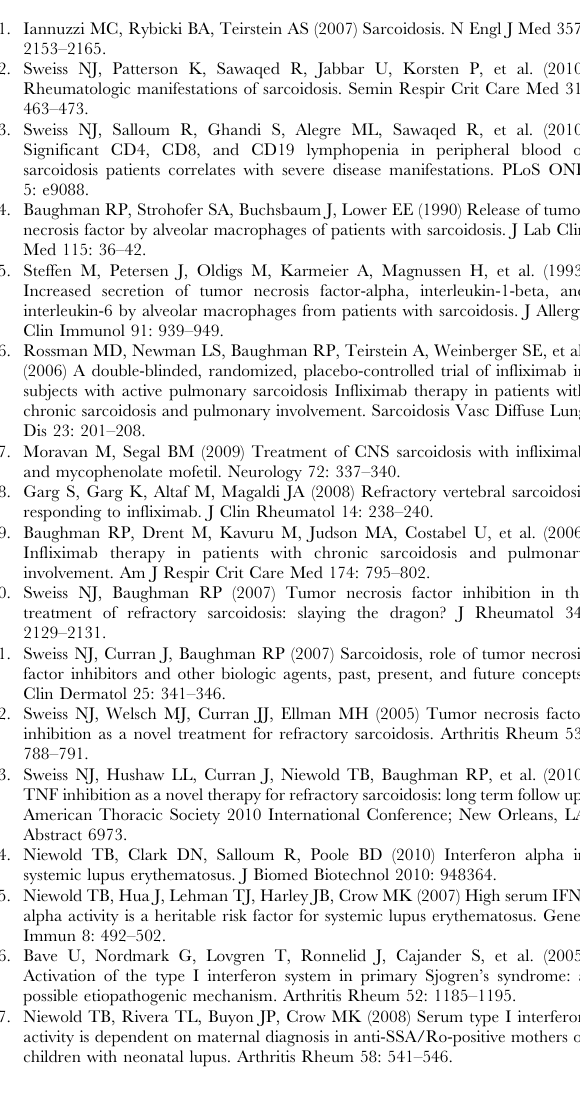
Figure S1 Association results after removing patients on TNF- a inhibitors. (A) Serum type I IFN activity is